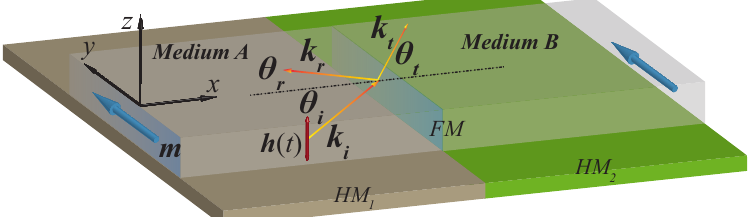
Figure 1. Schematic illustration of spin-wave transmission and reflection at an interface between media A and B with different interfacial DMI in a thin YIG film. The interfacial DMI step here is realized by utilizing two different HM layers (HM 1 and HM 2 ) below the YIG film. The blue arrows along the ˆ y direction denote the magnetization m . k i , k t and k r are the wave vectors of the incident, refracted and reflected spin-wave shown as the yellow and red arrows, respectively. θ i , t , r denote their angles with respect to the interface normal. The red double-headed arrow shows the Gaussian distribution AC Magnetic field h ( t ) exciting the